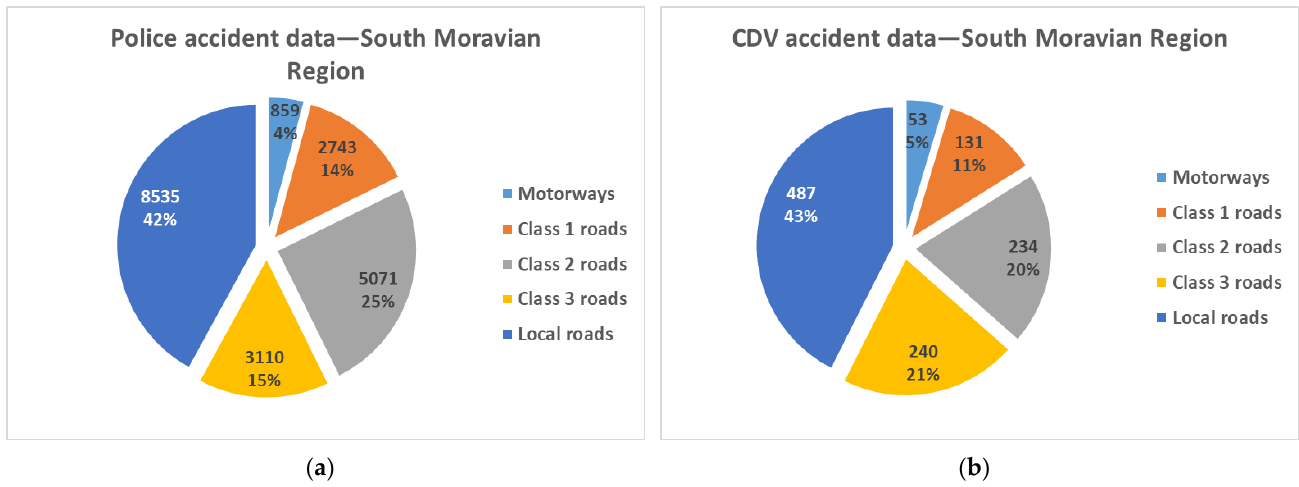
Figure 2. Comparison of police data on accidents involving injuries in the South Moravian Region for individual roads ( a ) with accidents investigated by the CDV ( b ) (2011–2019).